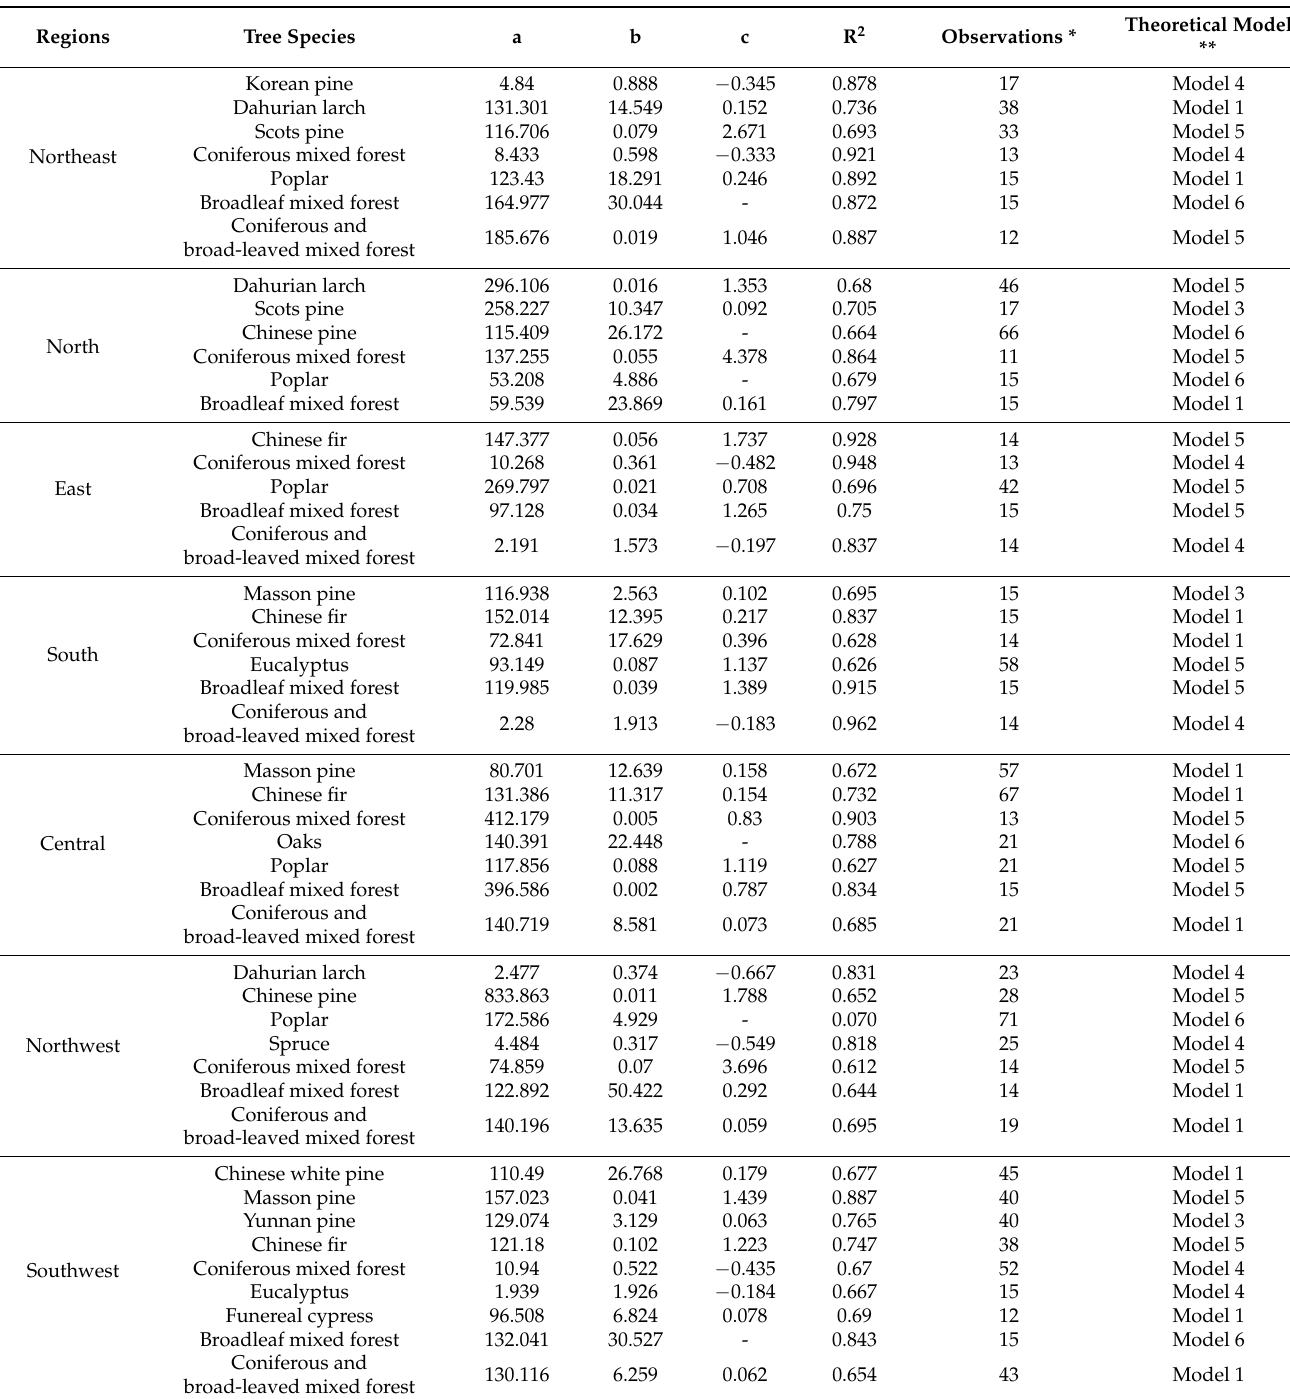
Table A3. Results of forest age-stand